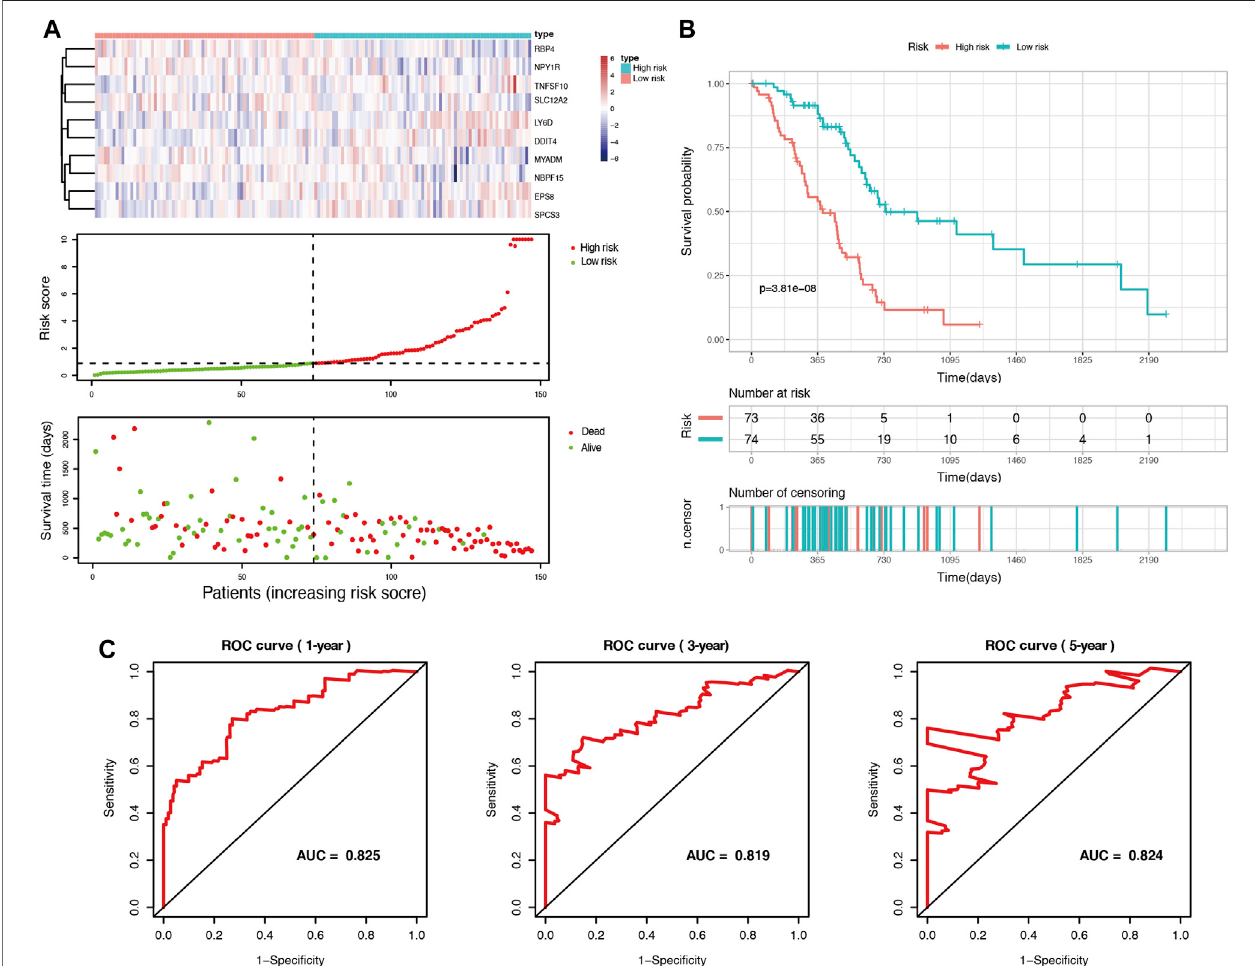
FIGURE 2 | Identi fi cation of prognosis-related genes and construction of a duct-cell-related risk model. (A) Risk score analysis in the TCGA training set. Upper panel: heatmap of gene expressions in the PDAC samples. Middle panel: risk score curve based on the ductal-cell-related genes signature. Bottom panel: patient survival status and time distributed by risk score. (B) Kaplan-Meier survival curve of the risk score for patient OS in the TCGA cohort. (C) The prognostic performance of the risk model is demonstrated by the time-dependent ROC curve for predicting the 1-, 3-, and 5-years OS rates in the TCGA training set.